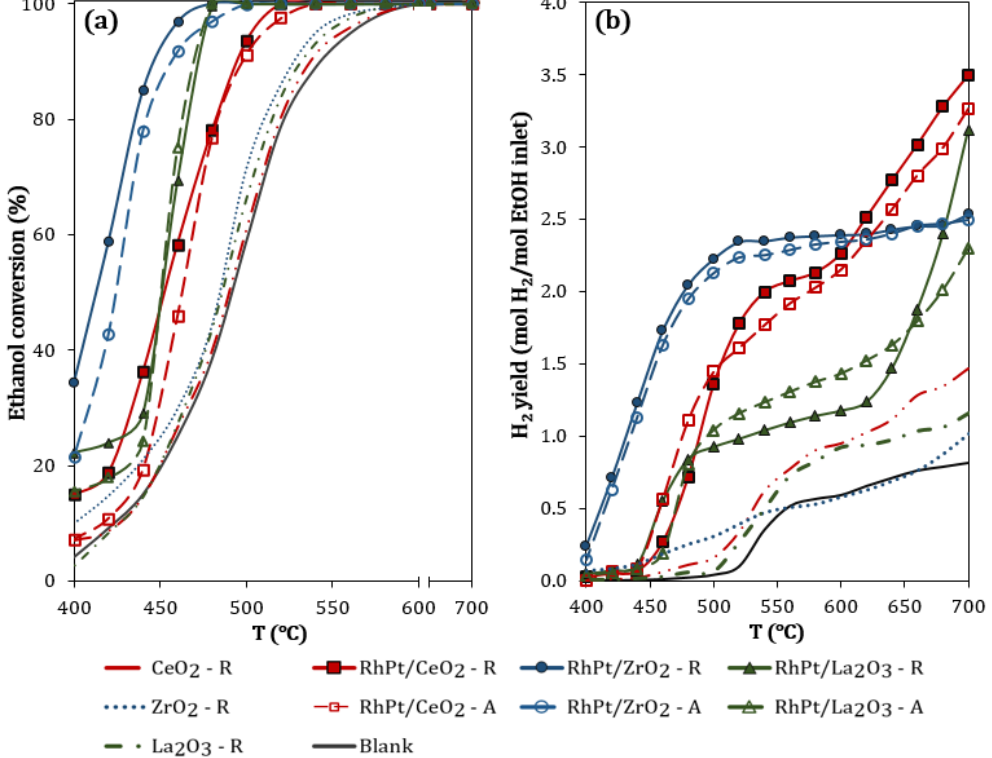
Figure 1. ( a ) Ethanol conversion (XEtOH) and ( b ) H 2 yield as a function of temperature for reduced (R) and aged (A) RhPt/CeO 2 , RhPt/ZrO 2 , and RhPt/La 2 O 3 . Reaction conditions: S/E = 3 and GHSV = 70600 h − 1 . Aged samples obtained after 27 h TOS at 700